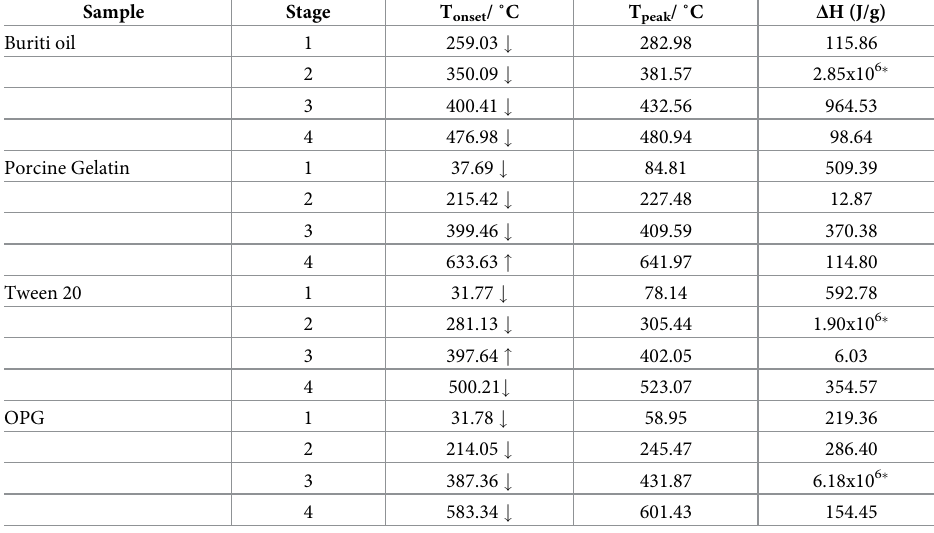
Table 2. The stages DTA of buriti oil, porcine gelatin, Tween 20, and OPG. Sample